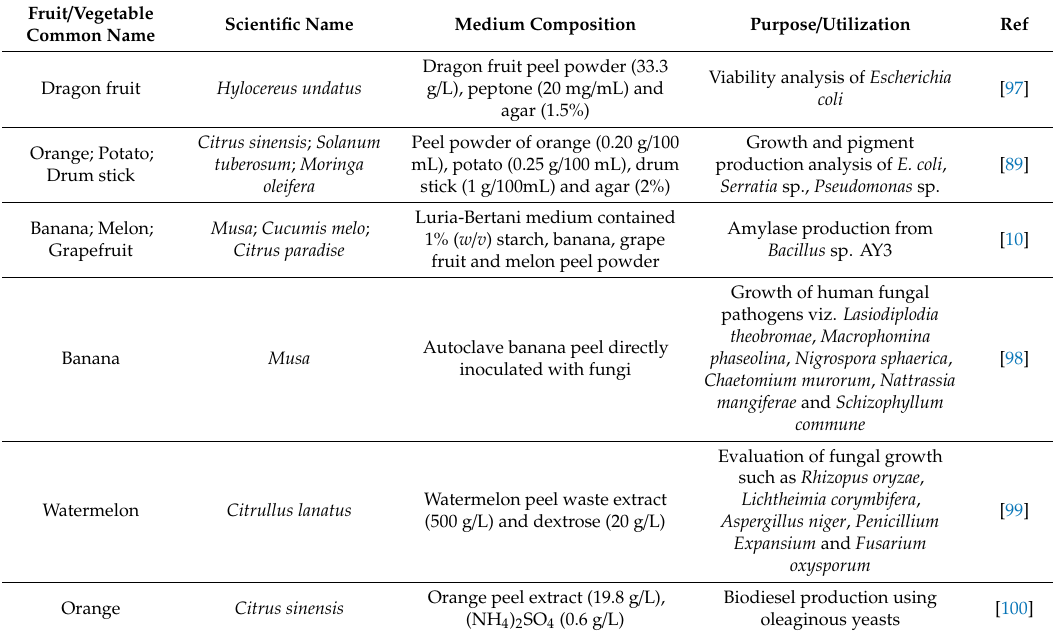
Table 4. Fruits and vegetables peel based microbiological